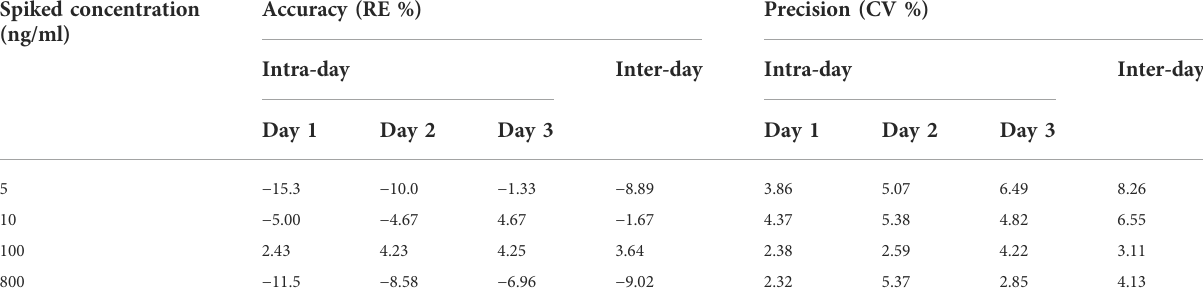
and − 9.02 – 3.64%, respectively. The ion enhancement or suppression of analytes in biological samples is expressed as a matrix effect, which should be close to 100% by optimizing the experimental conditions to avoid endogenous interference to the assay results. The matrix effects at concentrations of LQC and HQC were (109 ± 13)% and (102 ± 2.4)% for apatinib and (106 ± 2.6)% for IS, indicating that the matrix had no effect on the results of the assay. The recovery was evaluated at the same concentration as the matrix and showed (96.1 ± 3.0)% and (102 ±